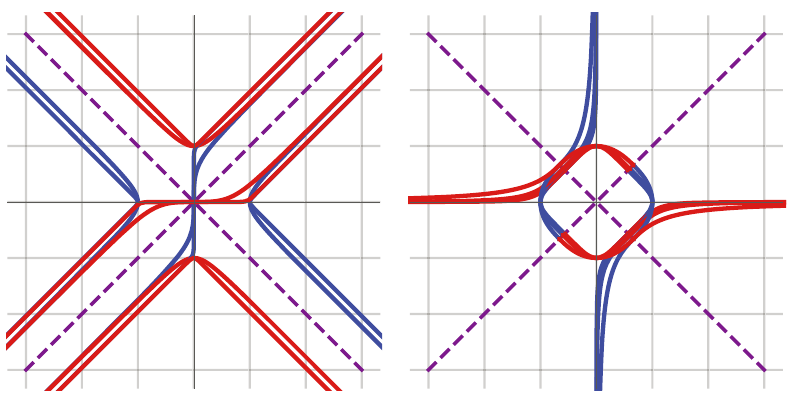
Figure 13: Lorentzian sinusoidal spirals in (cid:2) 2 with ≥ / n 5 2 ( left ) and ≤ / n −3 2 ( right ) , (cid:4) ∈ n